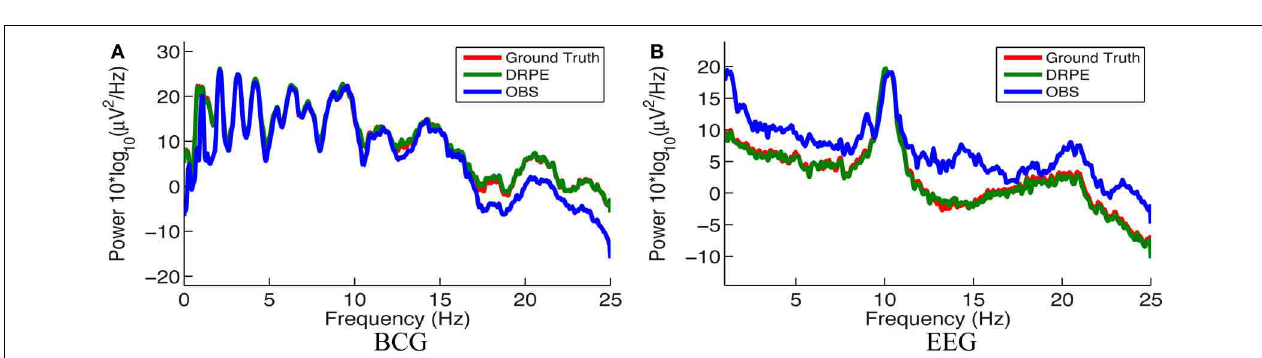
117.5% relative errors for BCG and EEG. The reconstructed BCG (A) from DRPE almost overlaps with the Ground truth BCG. The large spikes in reconstructed EEG (B) from OBS are due to the residual BCG signals.